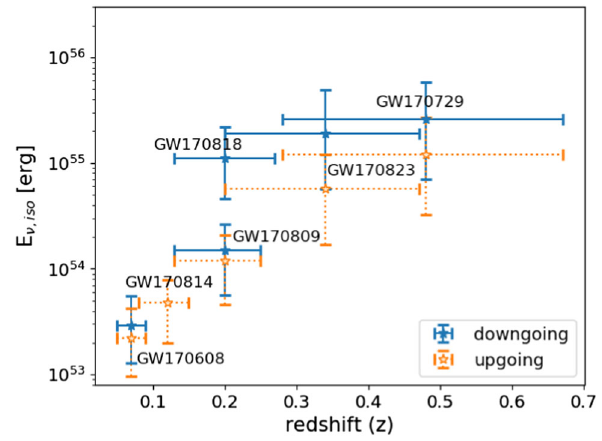
Fig. 2 90% CL upper limits on the total isotropic energy emitted in neutrinos within the 5–95% energy range of the search for the six GW events analysed asa function of the estimatedredshift. Resultsare given for the ANTARES downgoing (blue) and upgoing (orange) searches. The error bars in the X-axis correspond to the uncertainty on the dis- tance estimate. The error bars in the Y-axis indicate the maximum and minimum limits obtained within this redshift